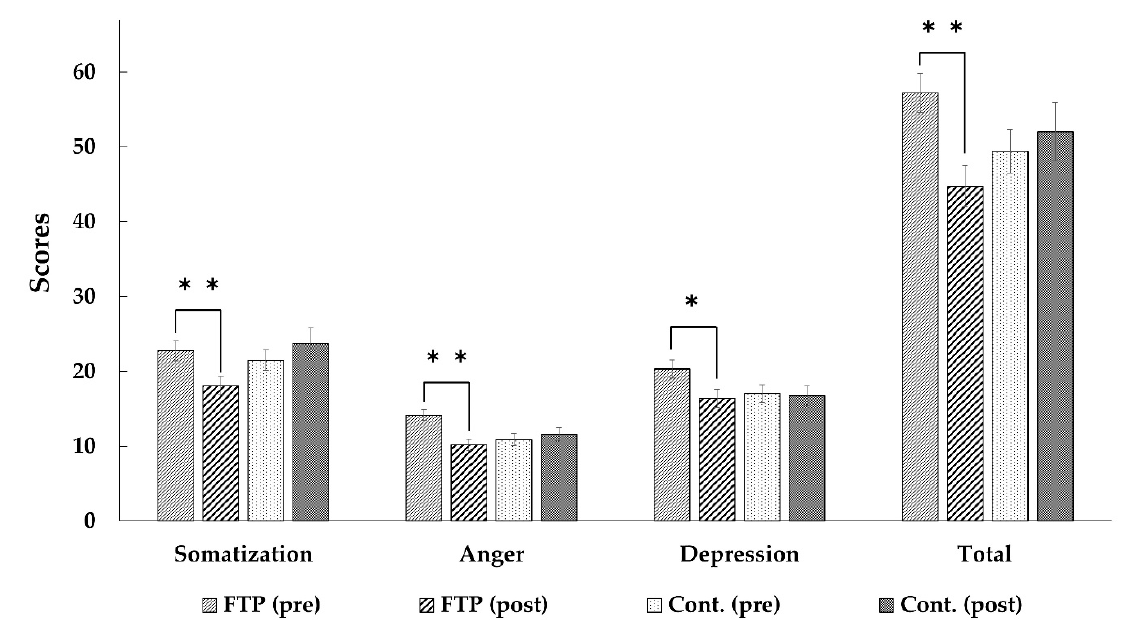
Figure 3. The results of paired t -test analyses of Modified Form of the stress response Inventory (SRI-MF) scores. FTP = Forest Therapy Program Group; Cont. = Control Group. ** p < 0.01, * p < 0.05.